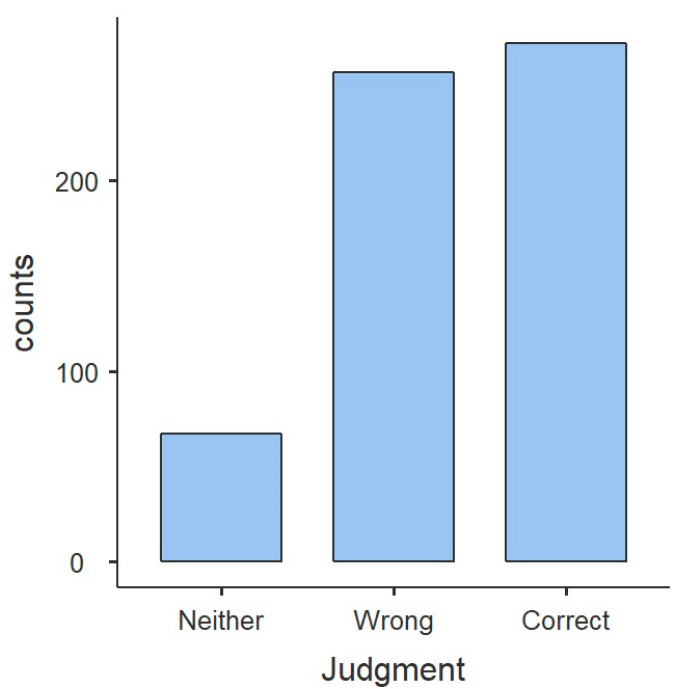
Figure 1. Acceptability judgments across participants and test items (596 data points). Correct/total: 45.6%, wrong/total: 43.1%, neither/total: 11.2%.